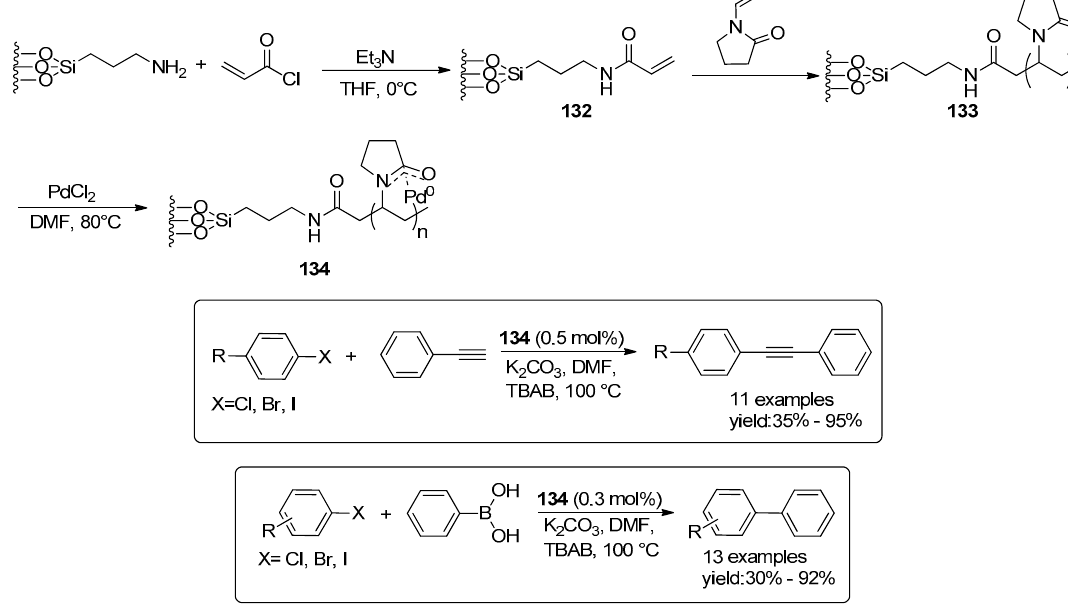
Scheme 48. Preparation of heterogeneous catalyst 134 and its use in cross-coupling